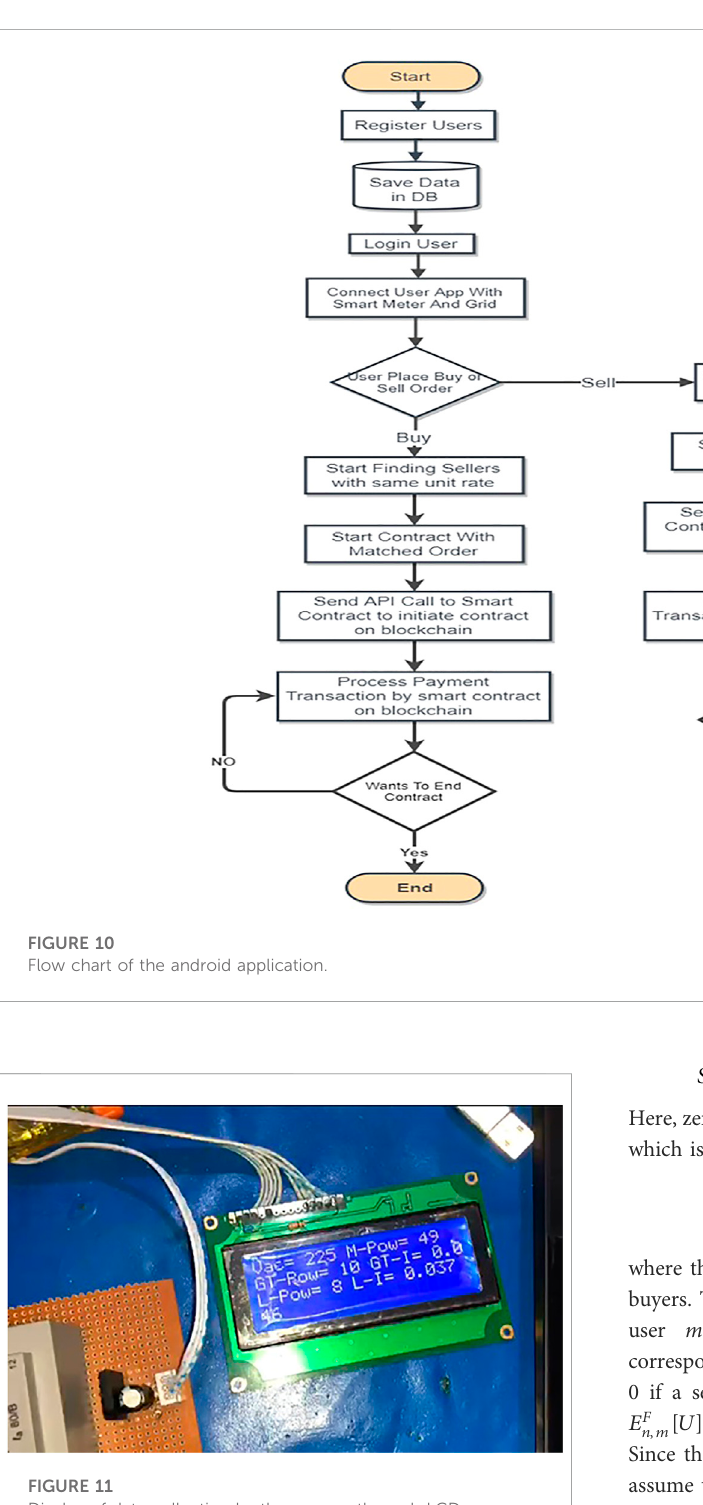
FIGURE 11 Display of data collection by the sensors through